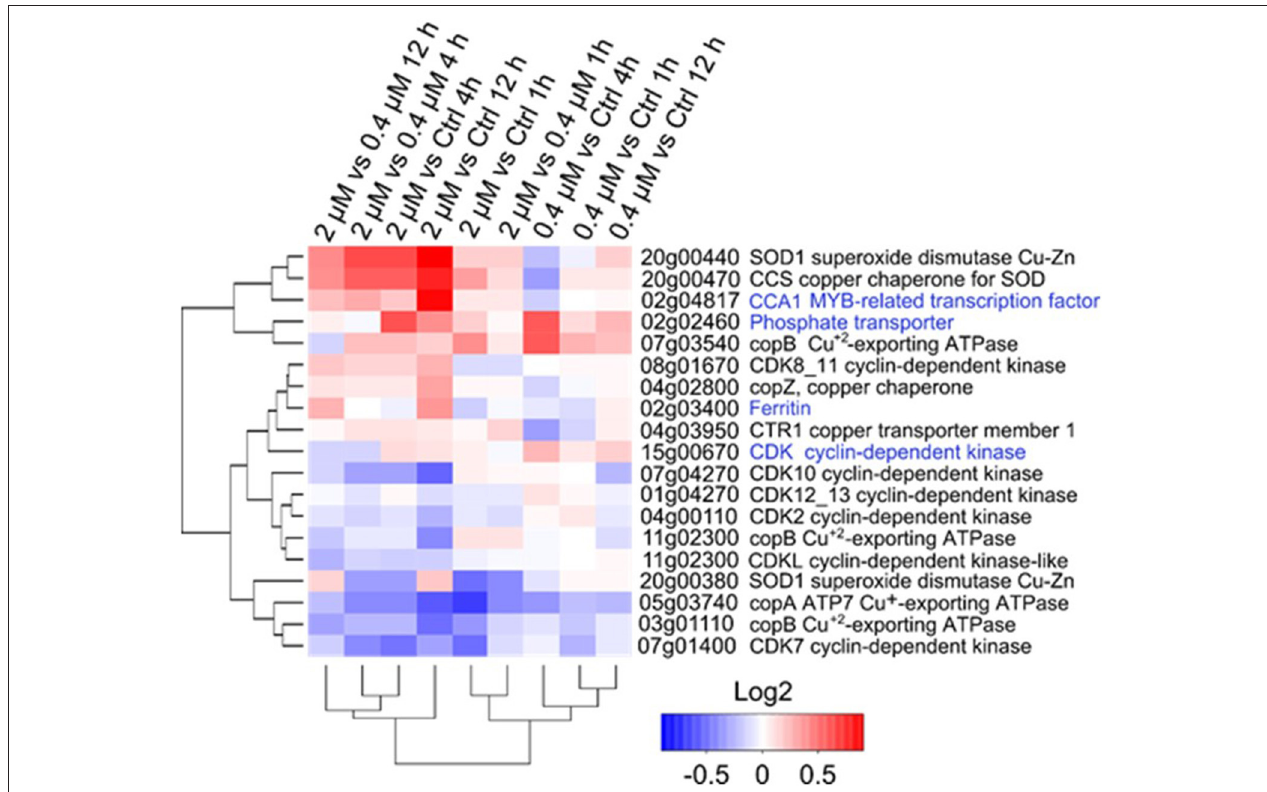
FIGURE 5 | Transcriptional changes of the tested genes after Cu exposure in O. tauri RCC745. Cluster analysis is based on Euclidian distances of the Log 2 fold-change values of genes for each treatment. Gene function for each transcript according to KEGG annotation is indicated at the right of the genomic location. Genes tested in the ecotoxicology analysis are highlighted in